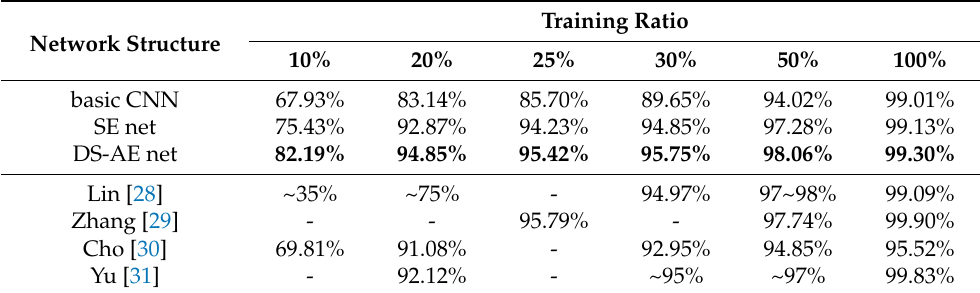
Table 6. Comparison of SAR target recognition rates for different training ratios. Network